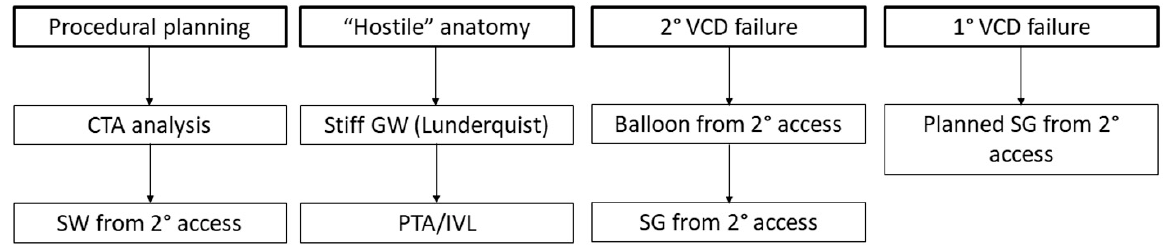
Figure 5. Flowchart for procedural planning and management of vascular complications. CTA, CT angiography; SW, safety wire; GW, guide wire; PTA, peripheral angioplasty; IVL, intravascular lithotripsy; VCD, vascular closure device; SG, stent graft. Development of TAVR systems with lower device profiles, as well as novel VCD designs with improved efficacy, may expand the role of TF TAVR and decrease the need for alternative vascular access in patients with hostile vascular anatomy.